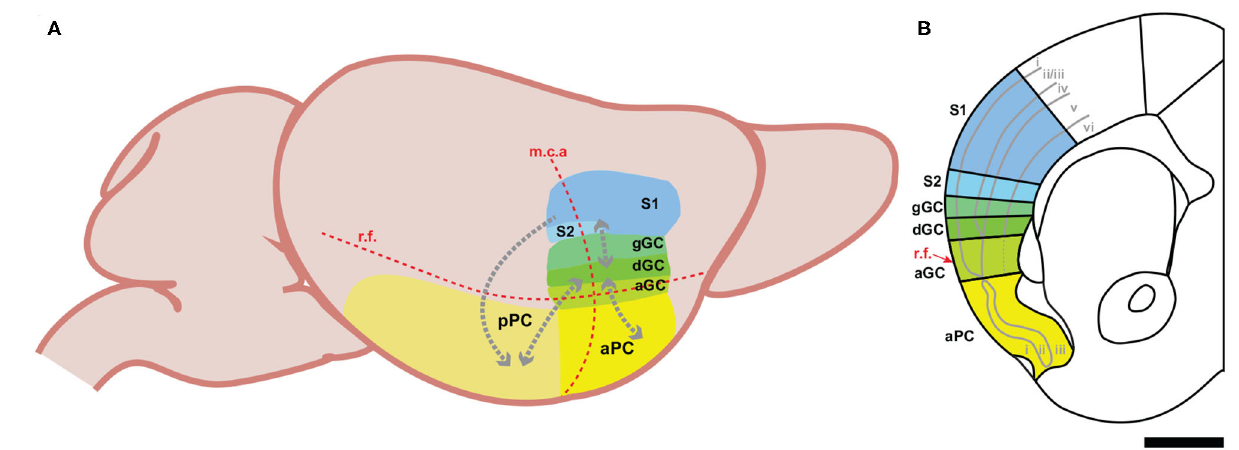
FIGURE 1 | Schematic representations of the three intraoral cortical regions in the mouse. (A) A lateral view displaying the relationship between the oral-somatosensory cortex, gustatory cortex, and olfactory cortex. The red dotted lines indicate the position of two key landmarks: the rhinal fissure (r.f.) and the middle cerebral artery (m.c.a.). The gray dotted arrows represent the corticocortical connections between regions. aGC, agranular gustatory cortex; dGC, dysgranular gustatory cortex; gGC, granular gustatory cortex; mca, middle cerebral artery; aPC, anterior piriform cortex; pPC, posterior piriform cortex; rf, rhinal fissure; S1, somatosensory cortex, area 1; S2, somatosensory cortex; area 2. (B) A coronal section of the mouse brain containing the oral-somatosensory cortex, gustatory cortex, and piriform cortex. The solid gray lines indicate the divisions between the cortical layers. Note the loss of layer 4 in the dysgranular gustatory cortex. The dotted gray line in the agranular gustatory cortex represents the fading boundary between layer 5 and layer 6, while the red arrow highlights the anatomical position of the rhinal fissure (r.f.). Black bar is